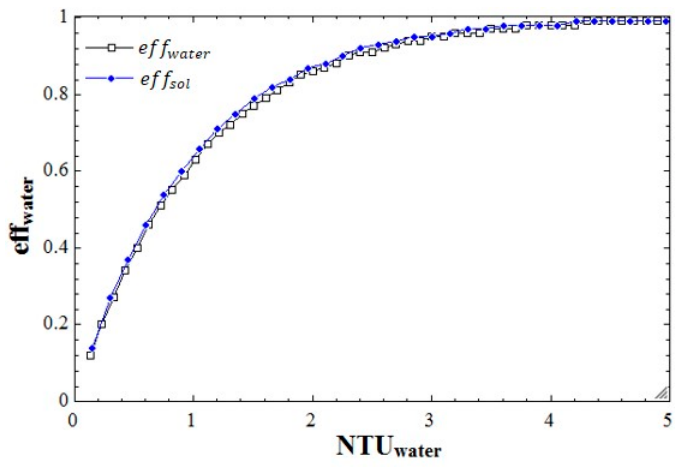
Figure 6. Effectiveness comparison between water and solution.